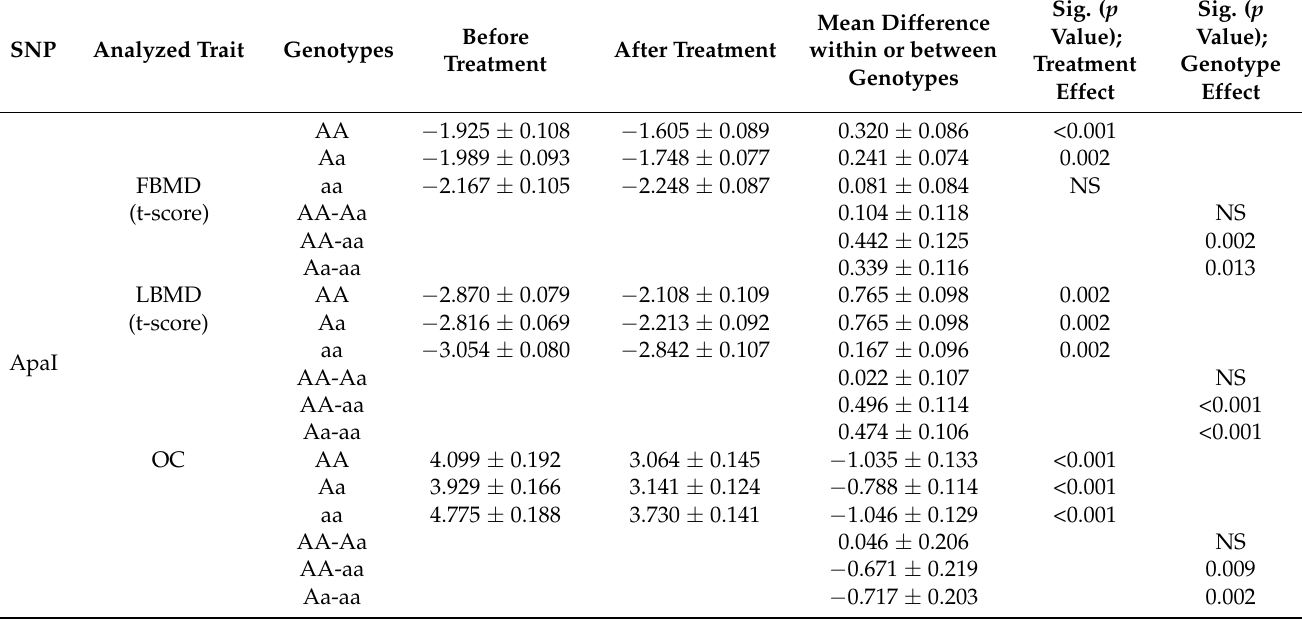
Table 7. Significant changes in osteoporosis-related traits after ibandronate therapy in relation to the VDR